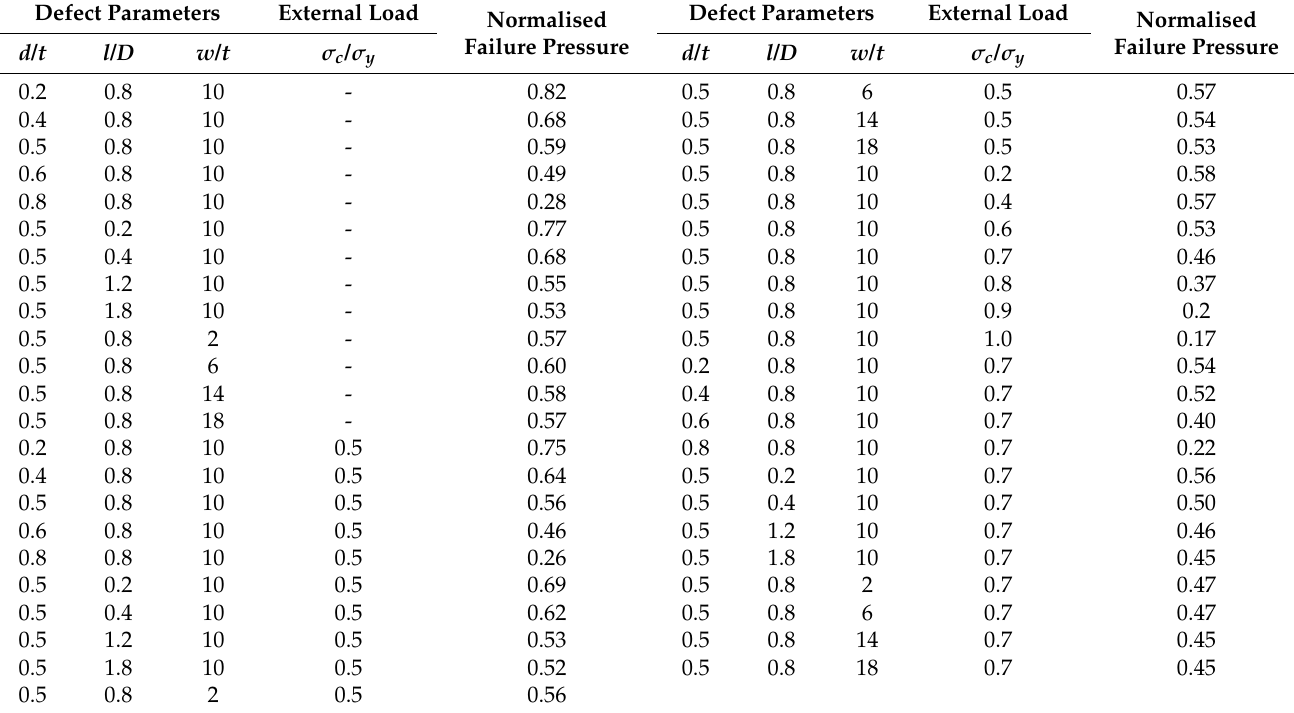
Table 5. FEA of corroded X65 pipeline with single corrosion defect subjected to internal pressure and longitudinal compressive